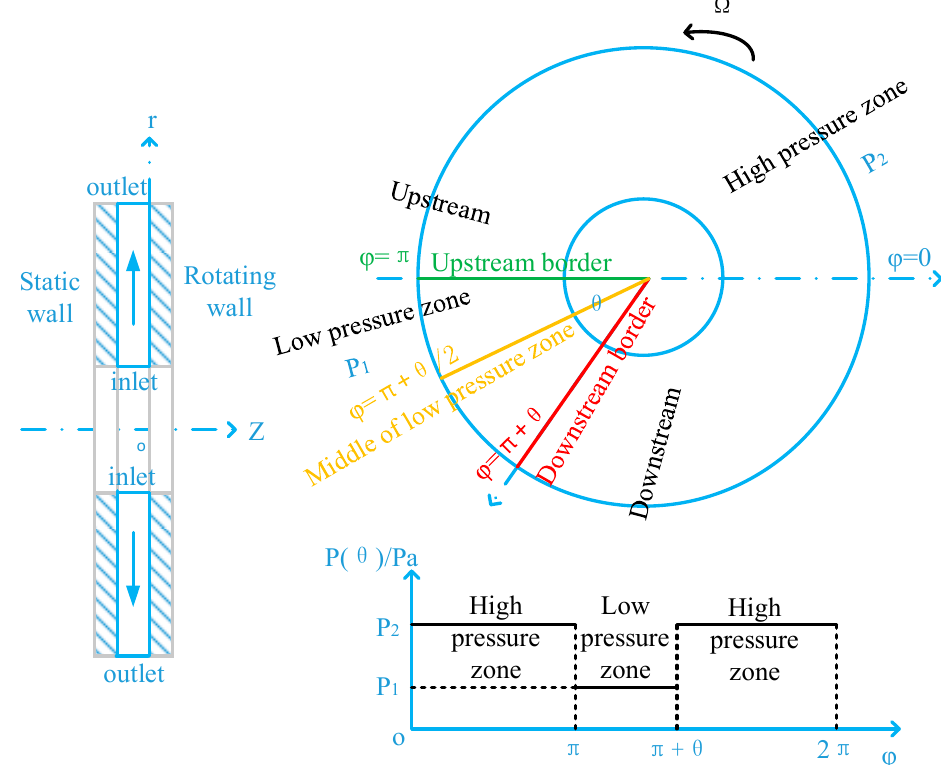
Figure 1. Computational model used in this